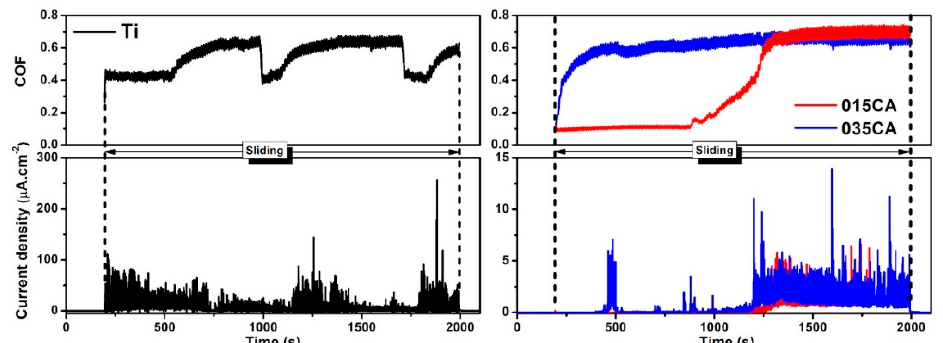
Figure 3. Evolution of current density before, during and after sliding, alongside the evolution of COF during sliding.